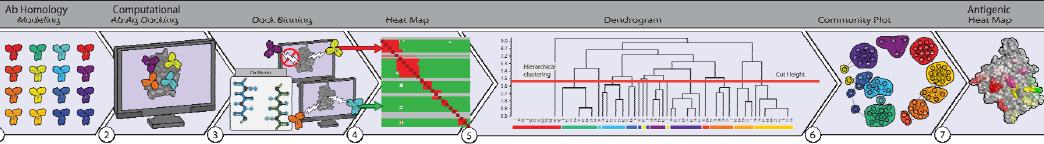
Figure 3. Schematic overview of “dock binning”, computational analysis of cross-competition of docking models of Abs against an Ag. Homology models of the Abs are computationally docked against a crystal structure or homology model of the Ag. Docking models are evaluated for “competition” and the extent of competition represented in a heatmap. The competition profiles are subsequently used to cluster docking models, with a community network representing the models (nodes), their competition (edges), and the identified clusters (groups of nodes). In contrast to experimental binning, dock binning is based on structural analysis and thus provides insights into where on the Ag the Abs might be interacting. The antigenic heatmap highlights the most popular Ag residues across the docking models; these are thus most generally informative for subsequent experimentally probing.